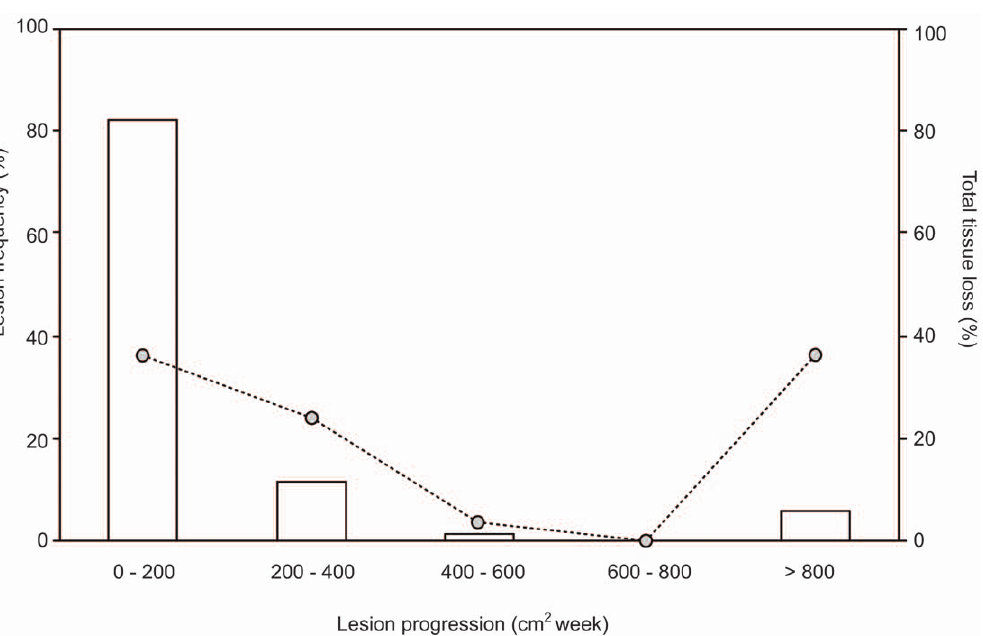
Figure 7. Size frequency distribution of lesion progression and tissue loss from Acroporid white syndrome colonies. Colonies monitored between March–August 2004.